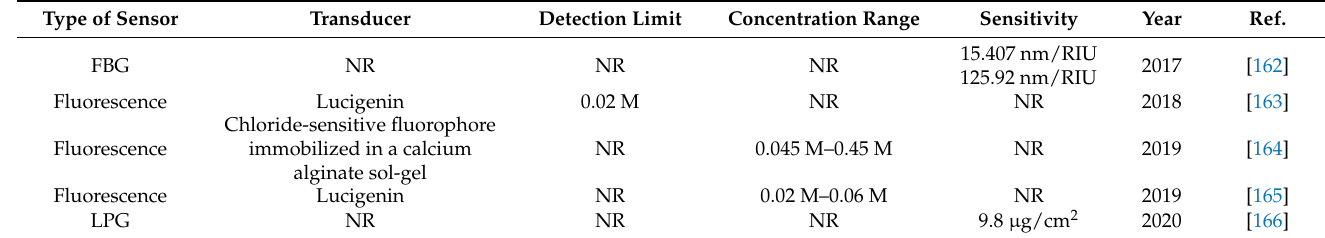
Table 2. Some sensors for chloride ion monitoring reported since